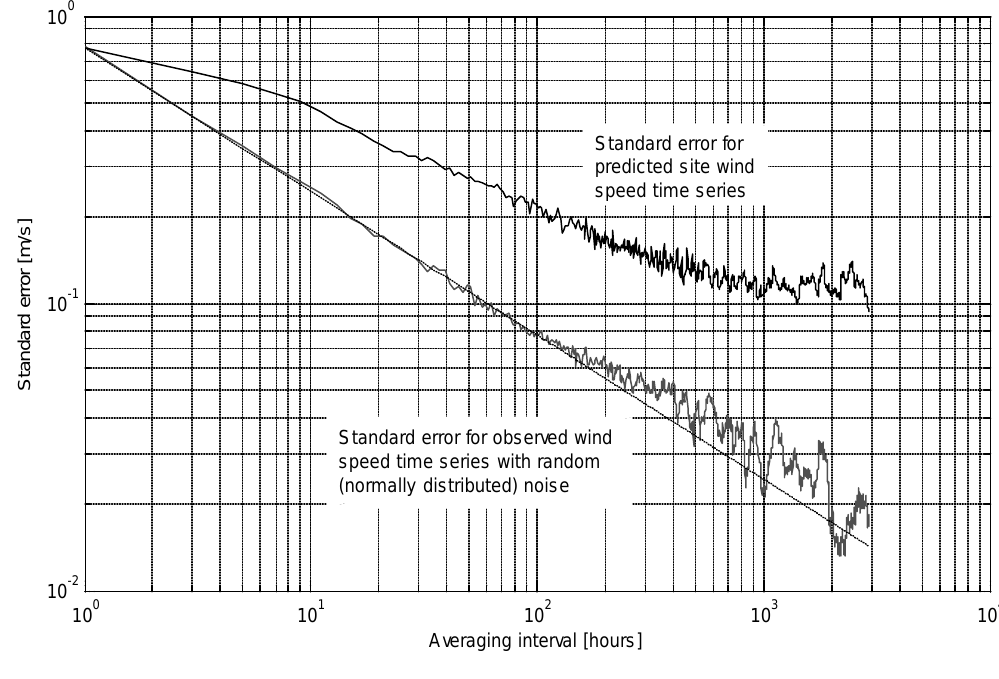
Figure 17. Evolution of the standard error of an MCP-derived wind speed prediction as a function of the averaging interval compared to the standard error obtained by adding normally distributed